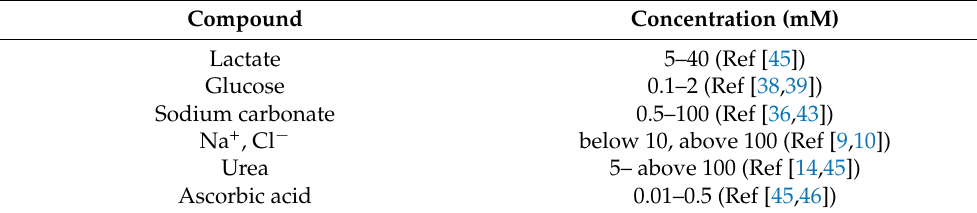
Table 1. Reference values for compounds of interest present in sweat.